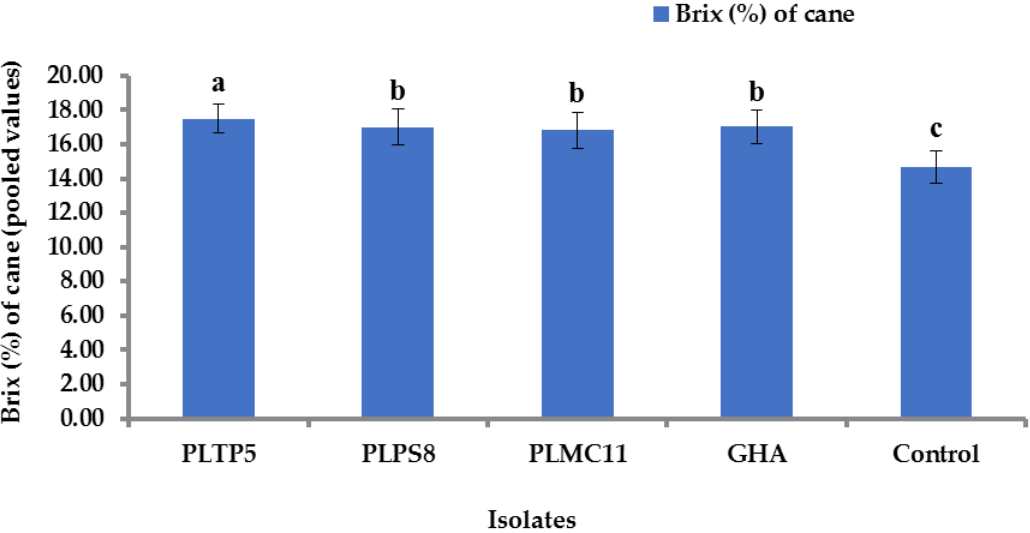
Figure 14. Effect of EPF conidia formulation application on the sugar content (brix%) of sugarcane. Different letters (a–c) in columns indicate significant differences ( p ≤ 0.05) among the isolates. Columns represent the mean ± SD ( n = 3). SD = standard deviation.